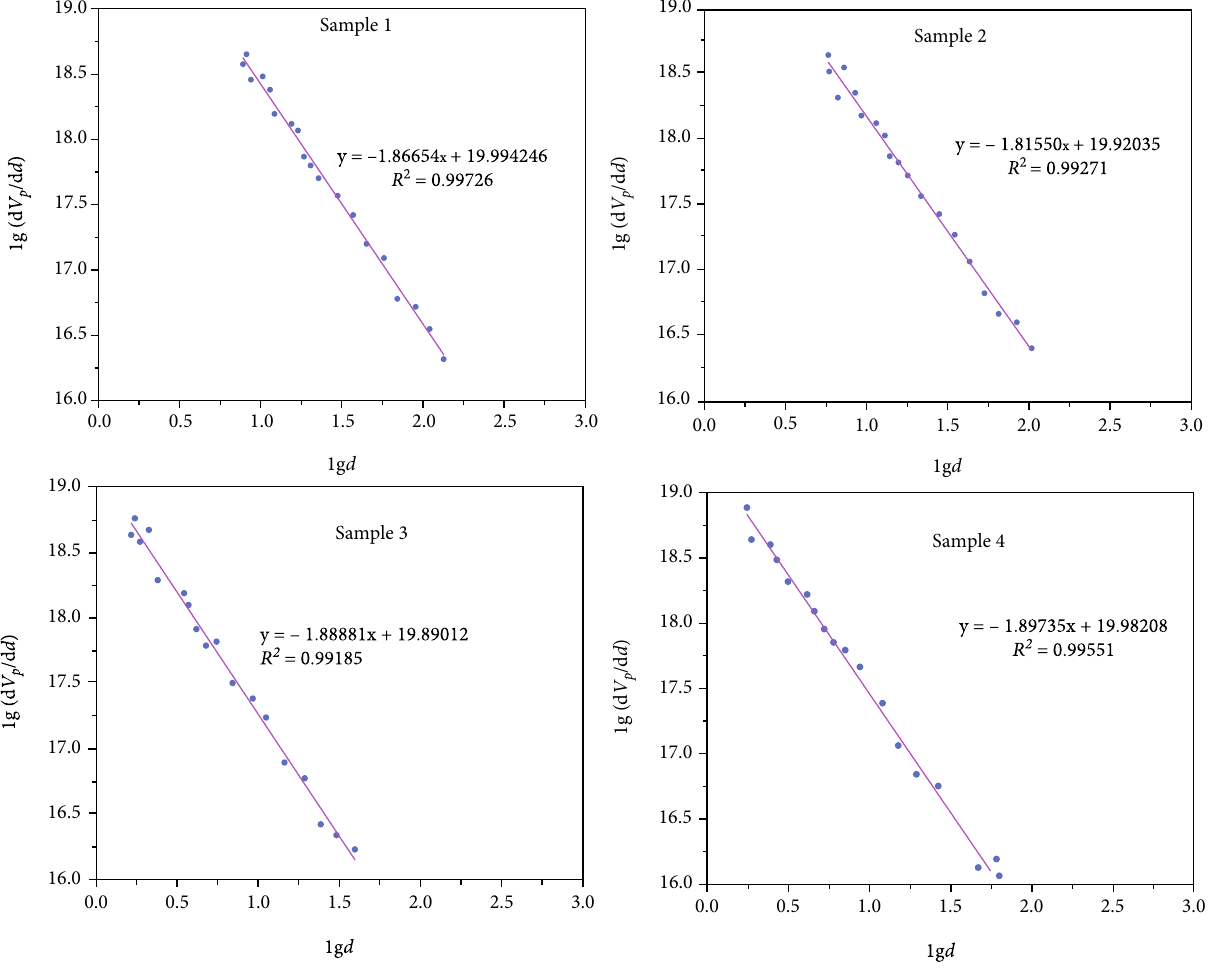
Figure 5: Fitting curves of lg ð dV